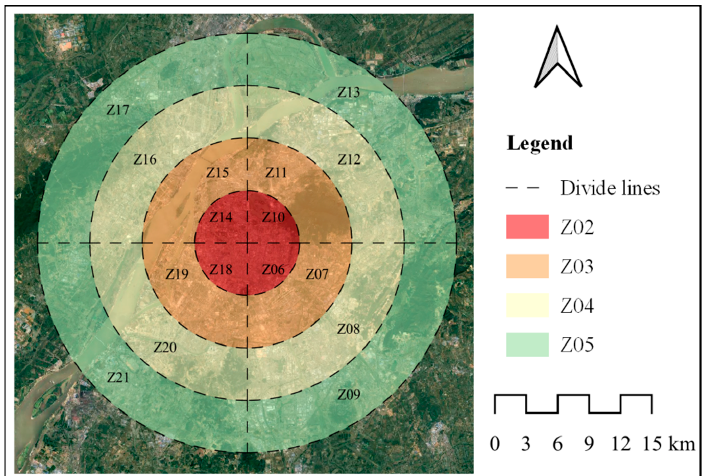
Figure 2. Partitioning of urban area as designed for Nanjing. The entire region was abbreviated as Z01, which covers the majority of the urban area. The concentric zones were distinguished with different colors (Z02–Z05). The concentric pie zones were annotated by text (Z06–Z21). Back ‐ ground from Google Earth Imagery [49]. The center was set at the Bronze Statue of Sun Yat ‐ sen in Nanjing.